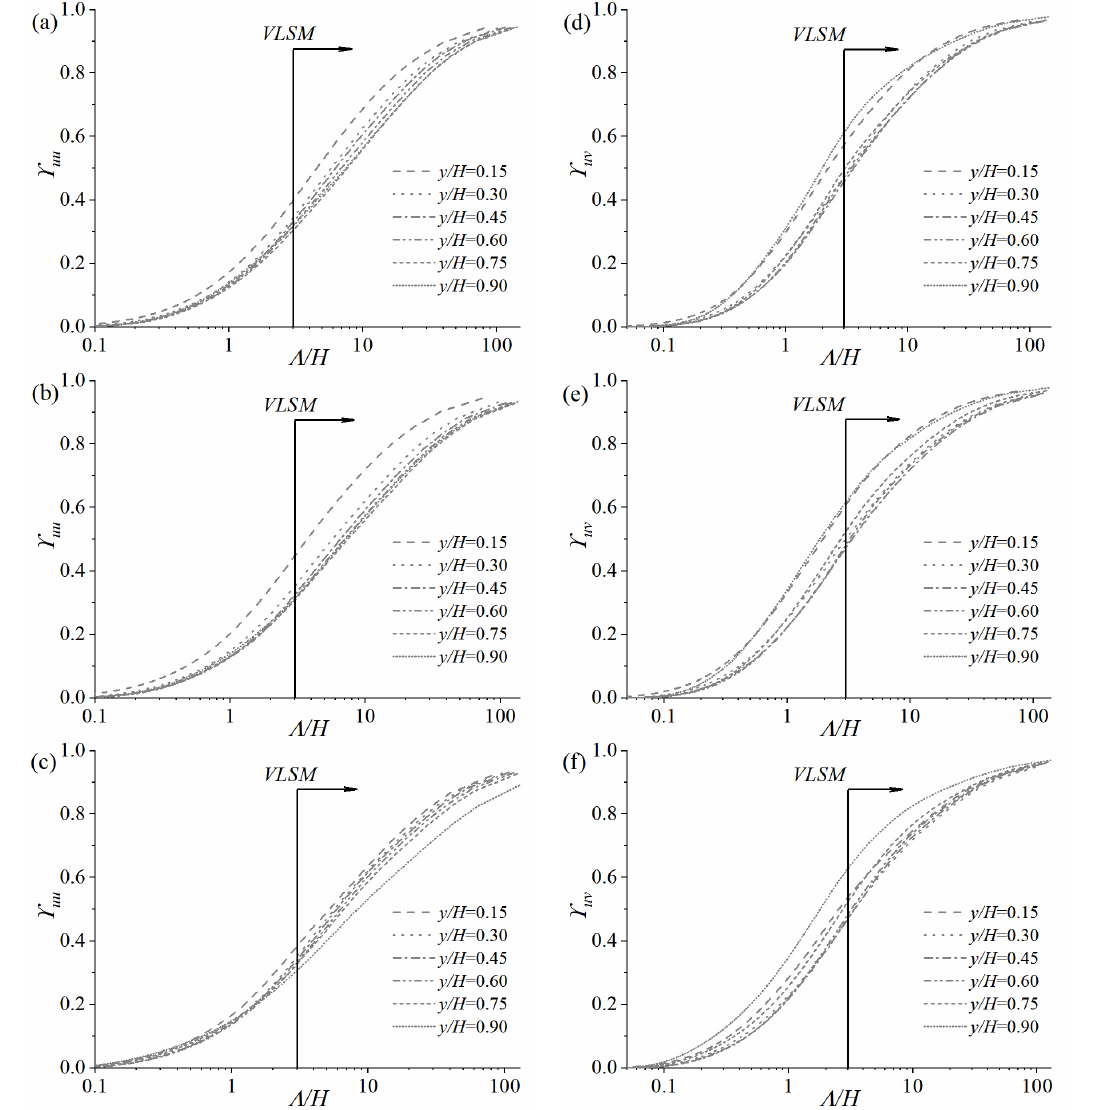
Figure 9. Cumulative contribution fractions of different scale structures to the streamwise kinetic energy ( g uu ) and Reynolds shear stress ( g uv ). ( a , d ) H055Re t 1780; ( b , e ) H075Re t 2760; ( c , f ) H100Re t 4110.